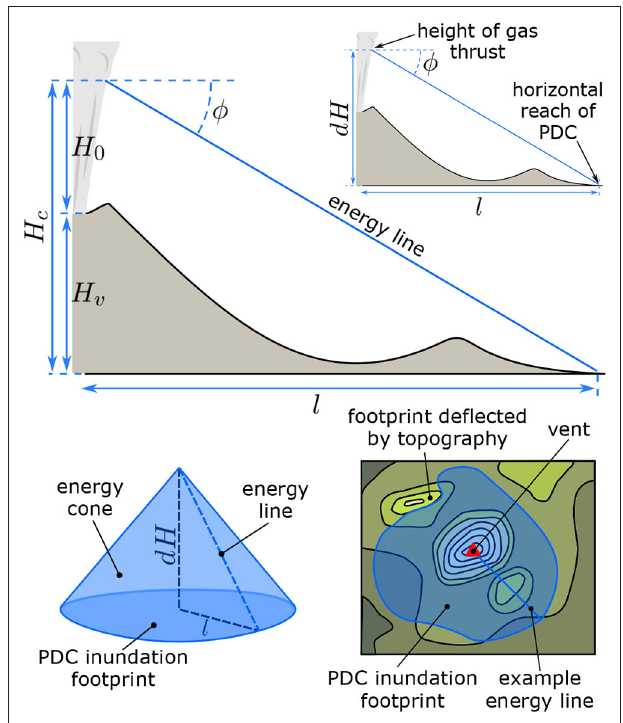
FIGURE 5 | The energy cone model of Malin and Sheridan (1982). Each PDC possesses a particular mobility ( φ ), derived empirically from dH and l of previous PDCs, and a estimated collapse height H c , derived from the height of the vent ( H v ) and the height of the gas thrust region ( H 0 ). The point at which an energy line dipping at mobility angle φ intersects the ground marks the expected distal reach of the PDC at that degree of azimuth. This process is repeated at every degree of azimuth around the vent to form an energy cone and a radial PDC inundation footprint. The footprint is perfectly circular on a flat surface, but is irregular where it meets irregular